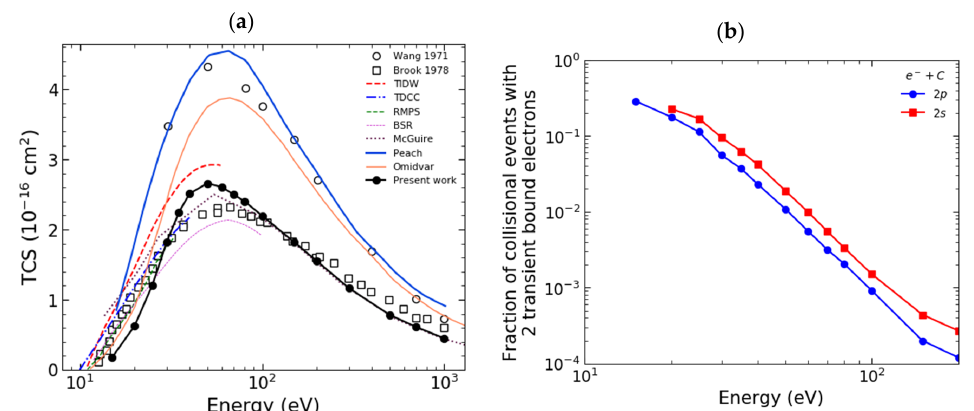
Figure 7. ( a ) Total ionization cross-section as a function of the impact energy for collisions of